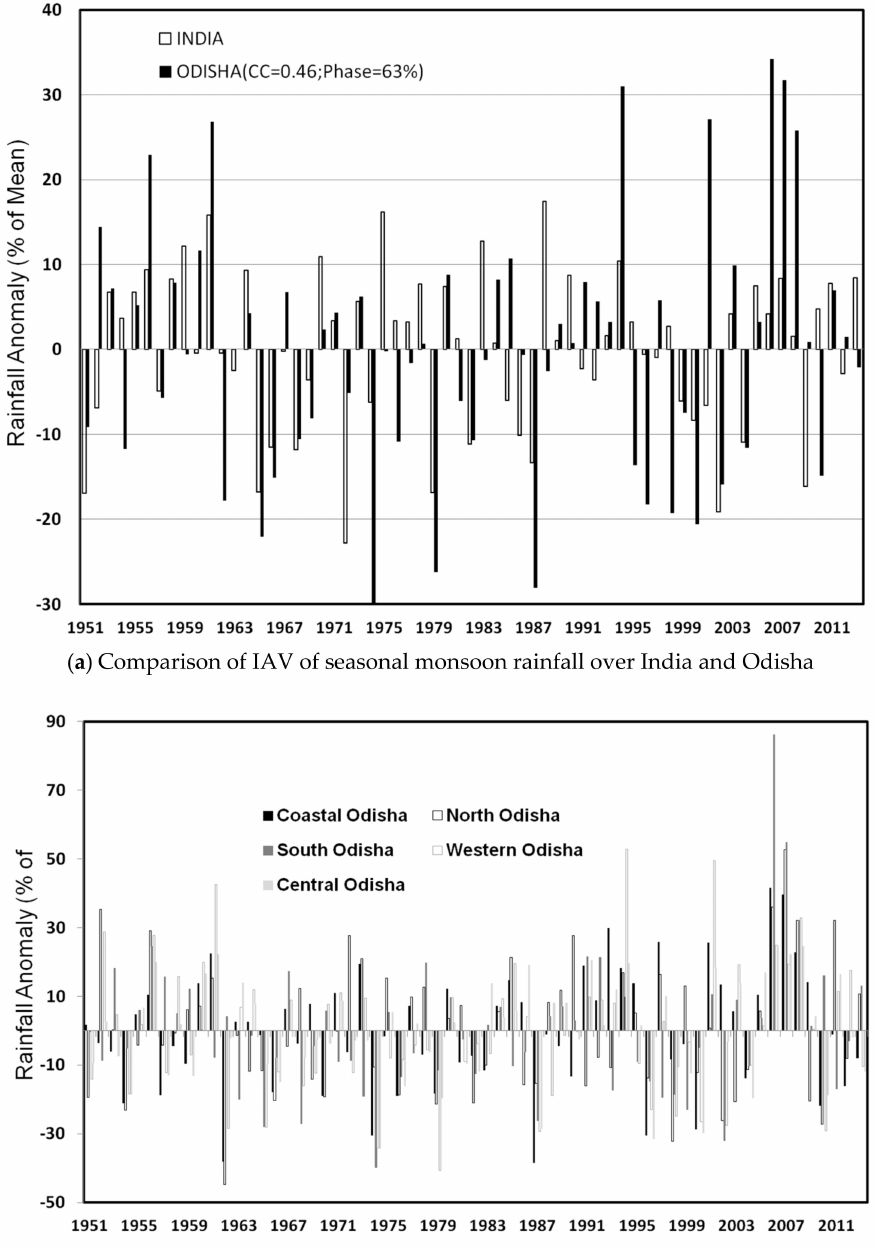
Figure 3. ( a ) Comparison of the interannual variability of monsoon (JJAS) rainfall anomaly over Odisha (filled bars) and India (hollow bars). The correlation co-efficient and phase of two IAVs are mentioned in parentheses; ( b ) Comparison of the interannual variability of the monsoon (JJAS) rainfall anomaly over different regions of Odisha for the period